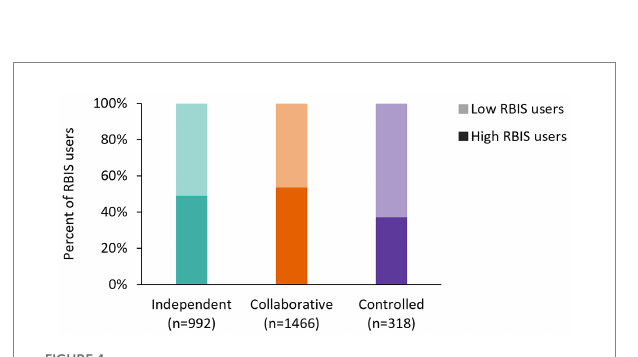
FIGURE 4 Percent of high RBIS users for each coordination